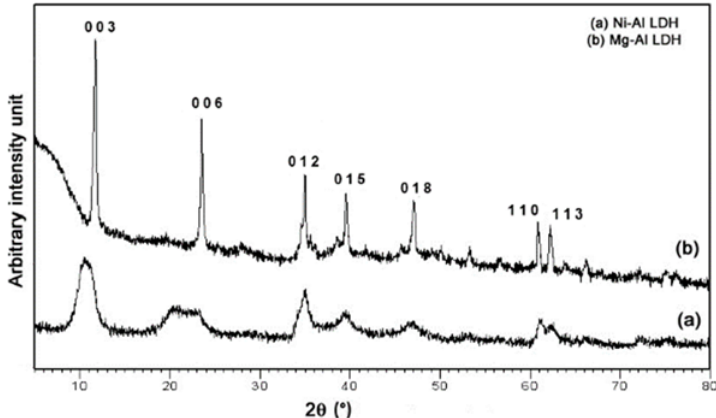
Figure 1. PXRD patterns of ( a ) NiAl nitrate and ( b ) MgAl carbonate layered double hydroxides (LDHs). On the graph, the hkl indexes of the main reflections are superimposed.